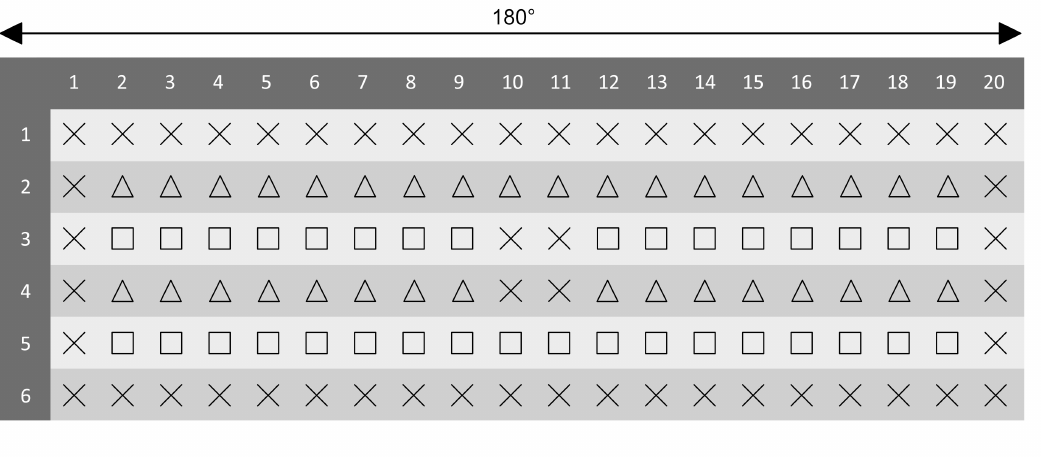
Figure 2. A two-dimensional overview of possible object spawning spanning the first 180 ◦ of each imaginary circle. There were three possible placement options in total: Distractor but no target ( X ), distractor and target for the new configuration ( triangle ) and distractor and target for the repeated configuration ( square